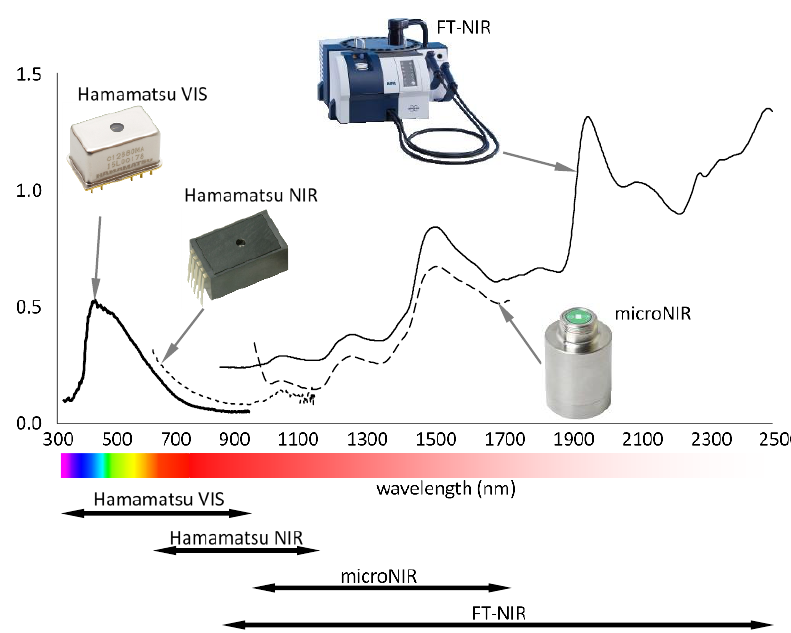
Figure 2. Absorbance spectra measured on the wood surface by different instruments evaluated.